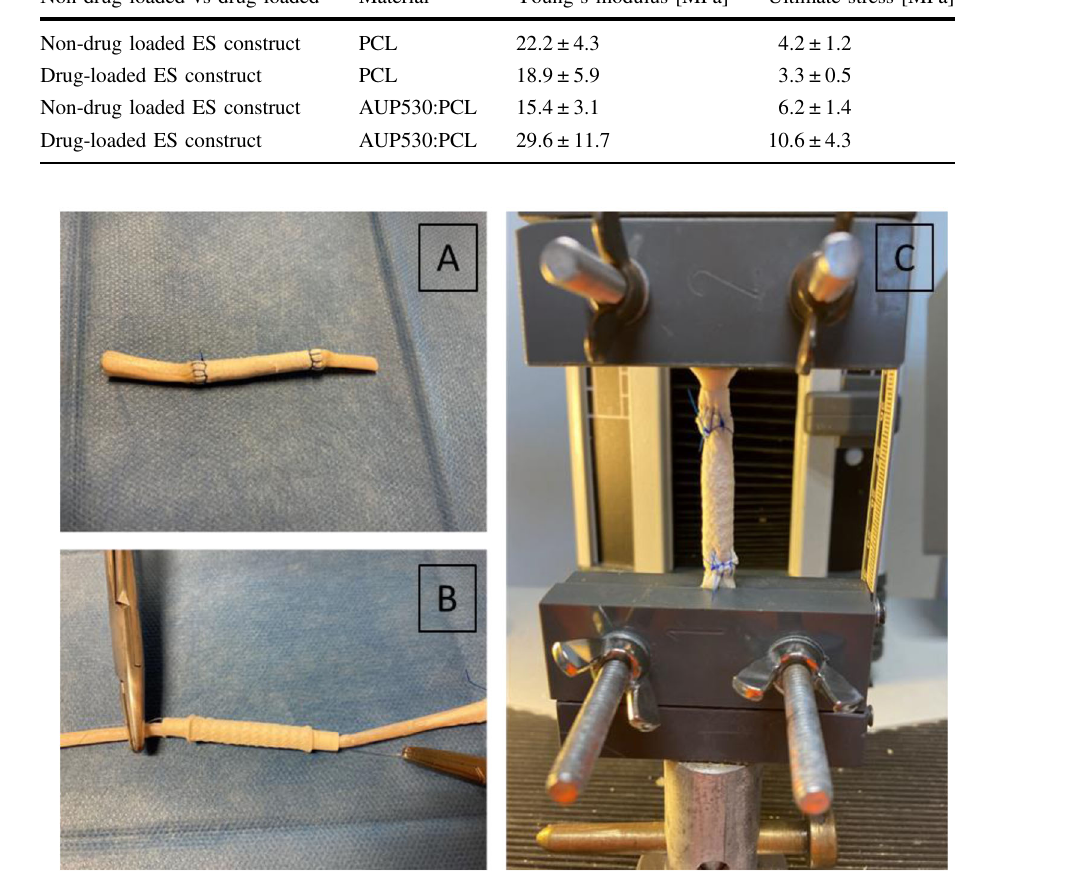
Table 3 Overview of the obtained Young moduli (MPa) and ultimate stresses (MPa) for ES constructs